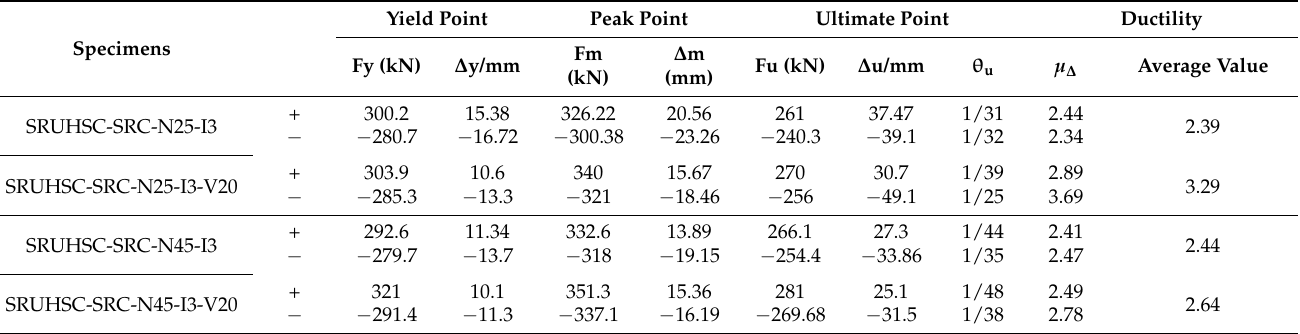
Table 4. Skeleton curve